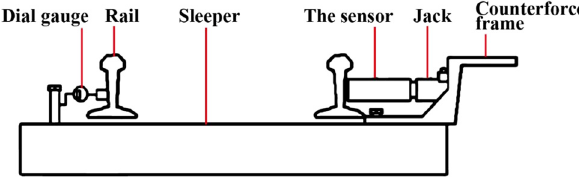
Figure 1: Schematic diagram of transverse resistance test of